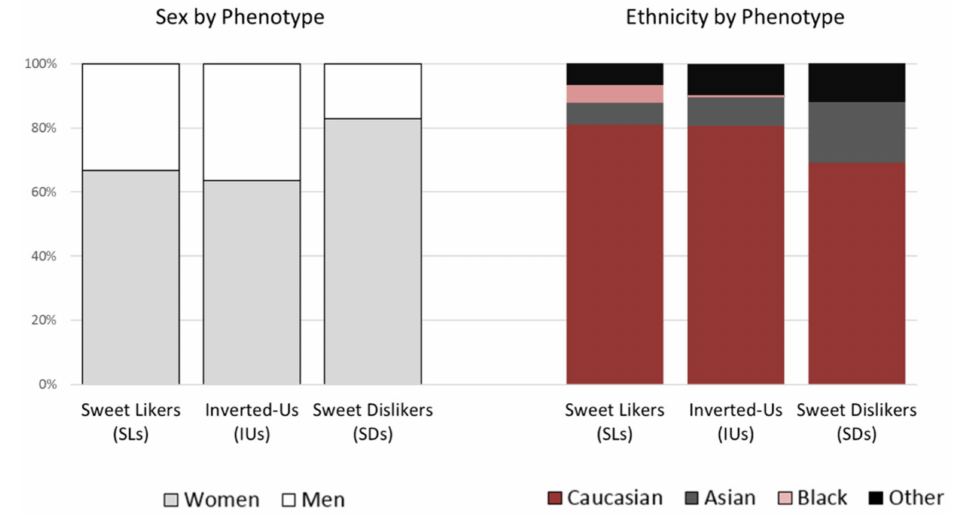
Figure 2. Proportion (%) of sexes and ethnicities by